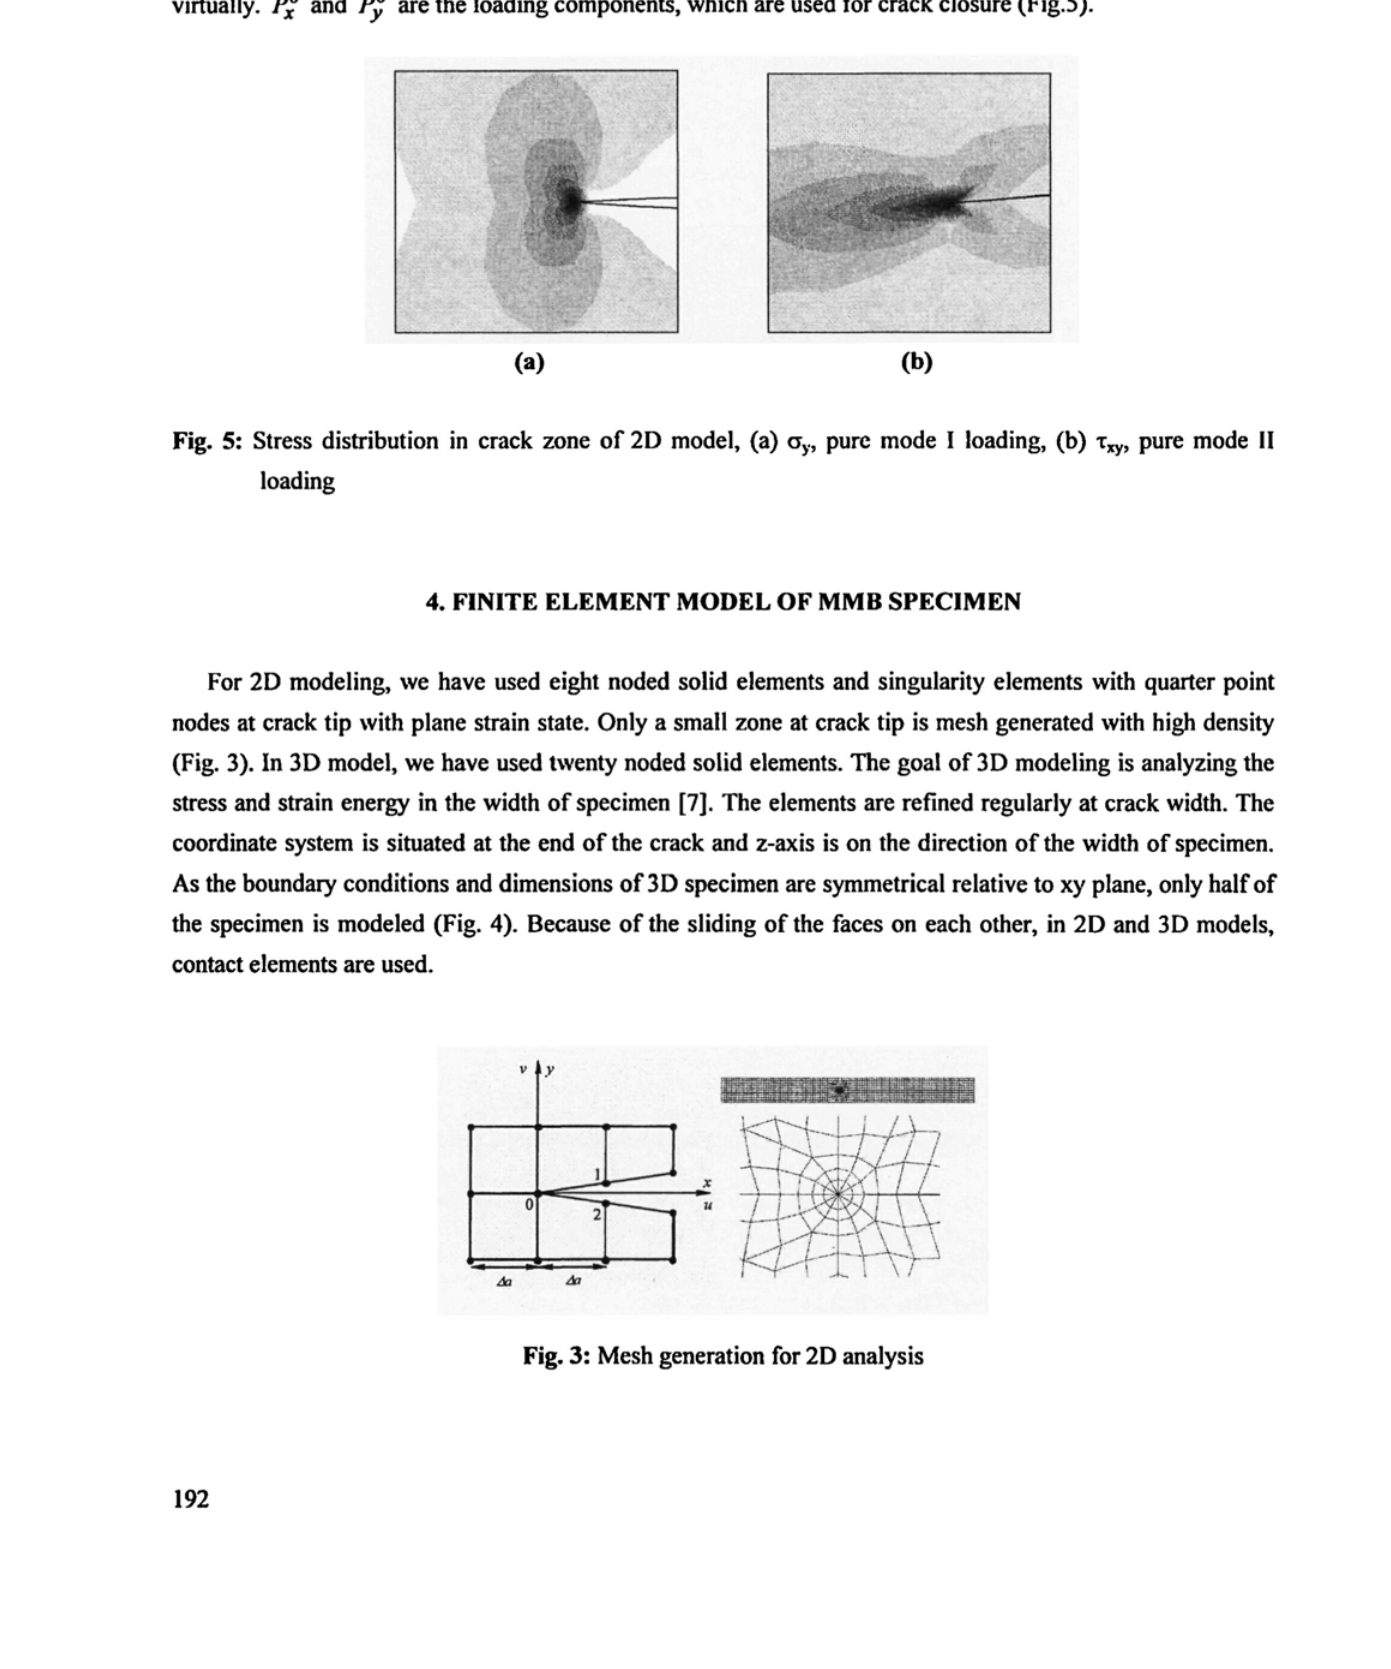
Fig. 3: Mesh generation for 2D